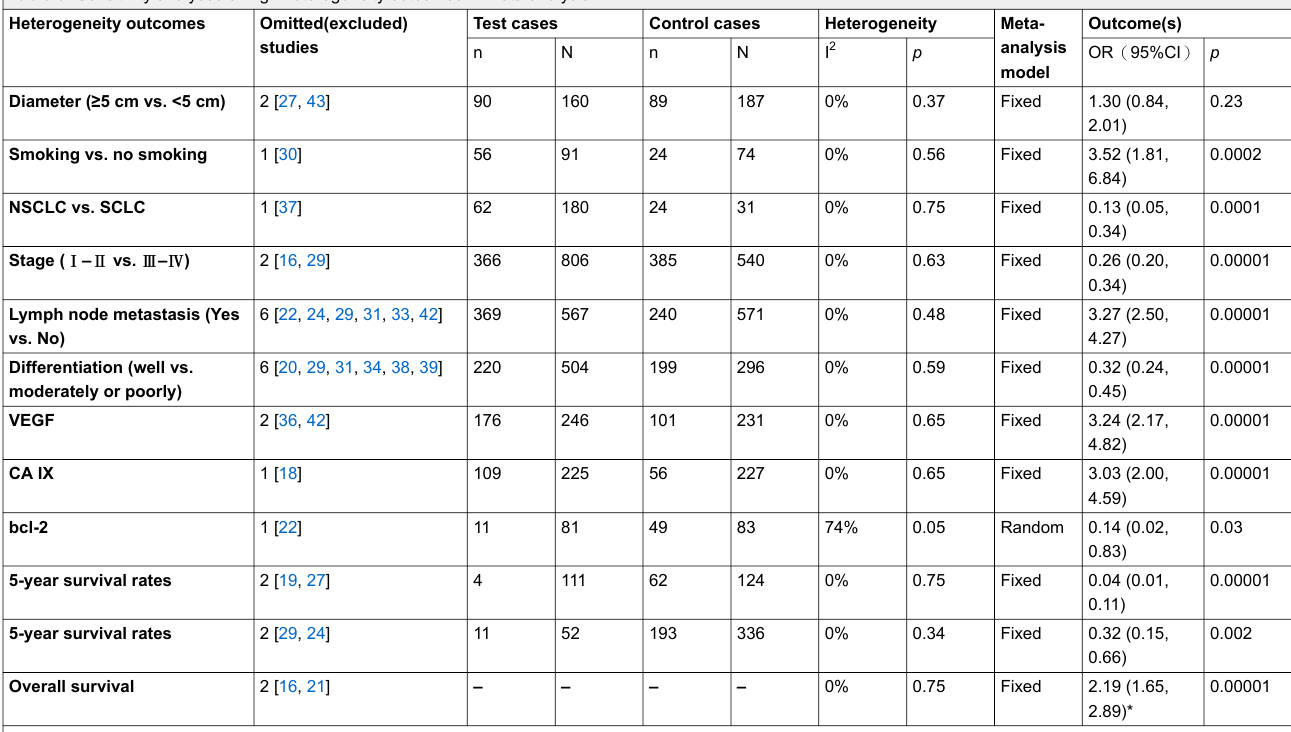
Table 3: Sensitivity analyses of high heterogeneity outcomes in